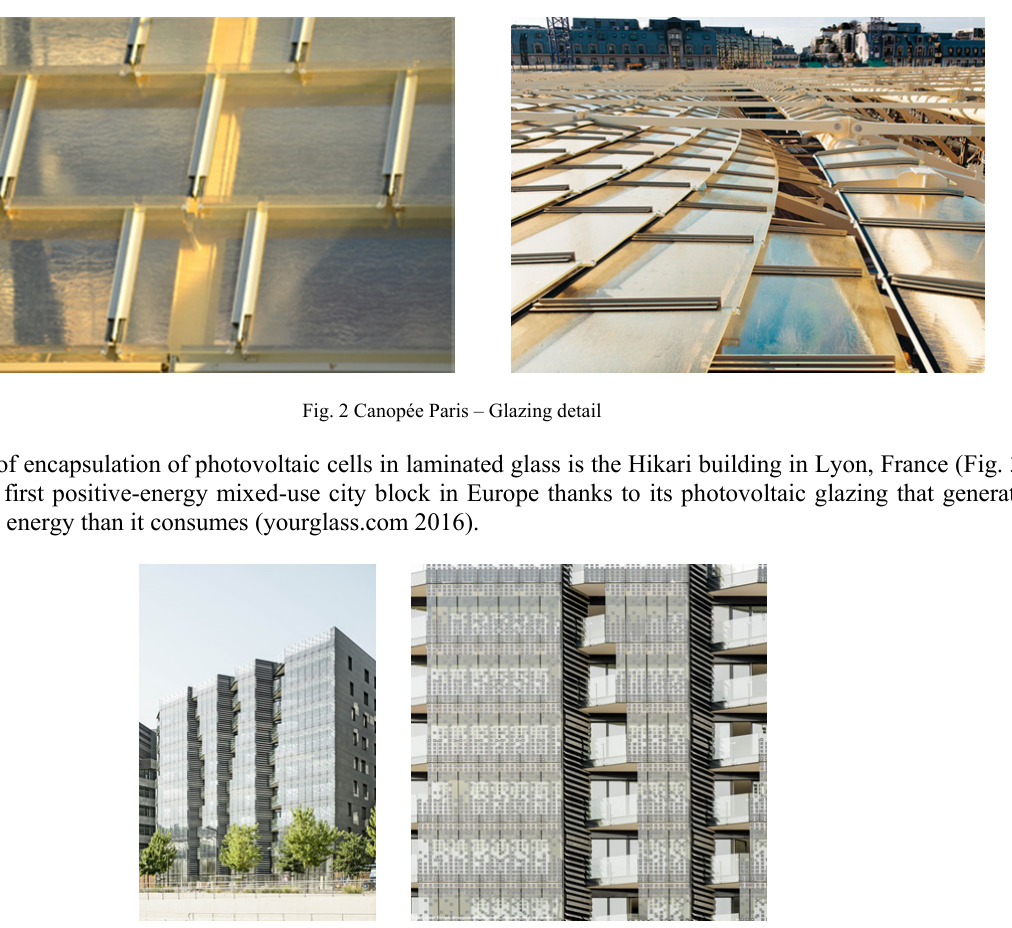
Fig. 3 Hikari Lyon – Global